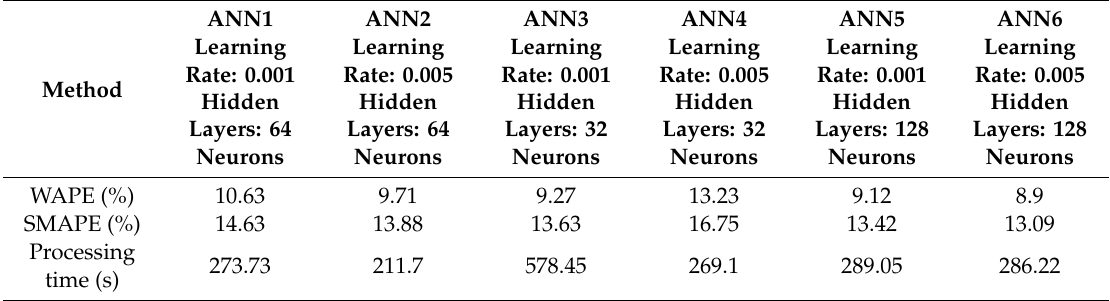
Table 1. Forecast result errors with di ff erent ANN method architectures. WAPE: weighted absolute percentage error; SMAPE: symmetric mean absolute